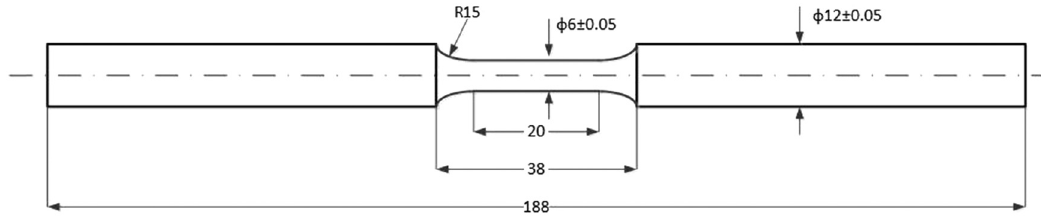
Figure 1: The geometry of specimen used in the test ( dimensions in mm ) .